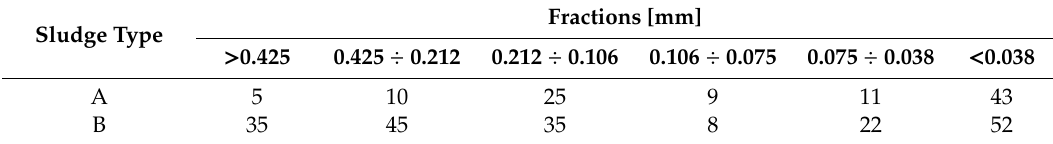
Table 3. Quartz content of sawing sludge (values in percent).